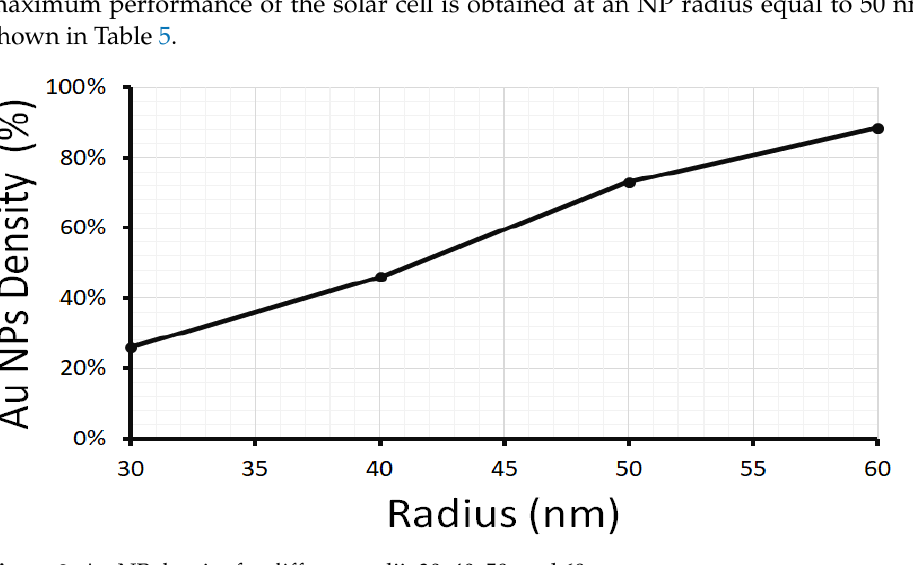
Table 5. Au NP density, short-circuit current density, and overall efficiency for different NP mate- rials. Table 6. Short-circuit current density and overall efficiency for different distances between NWs. Period